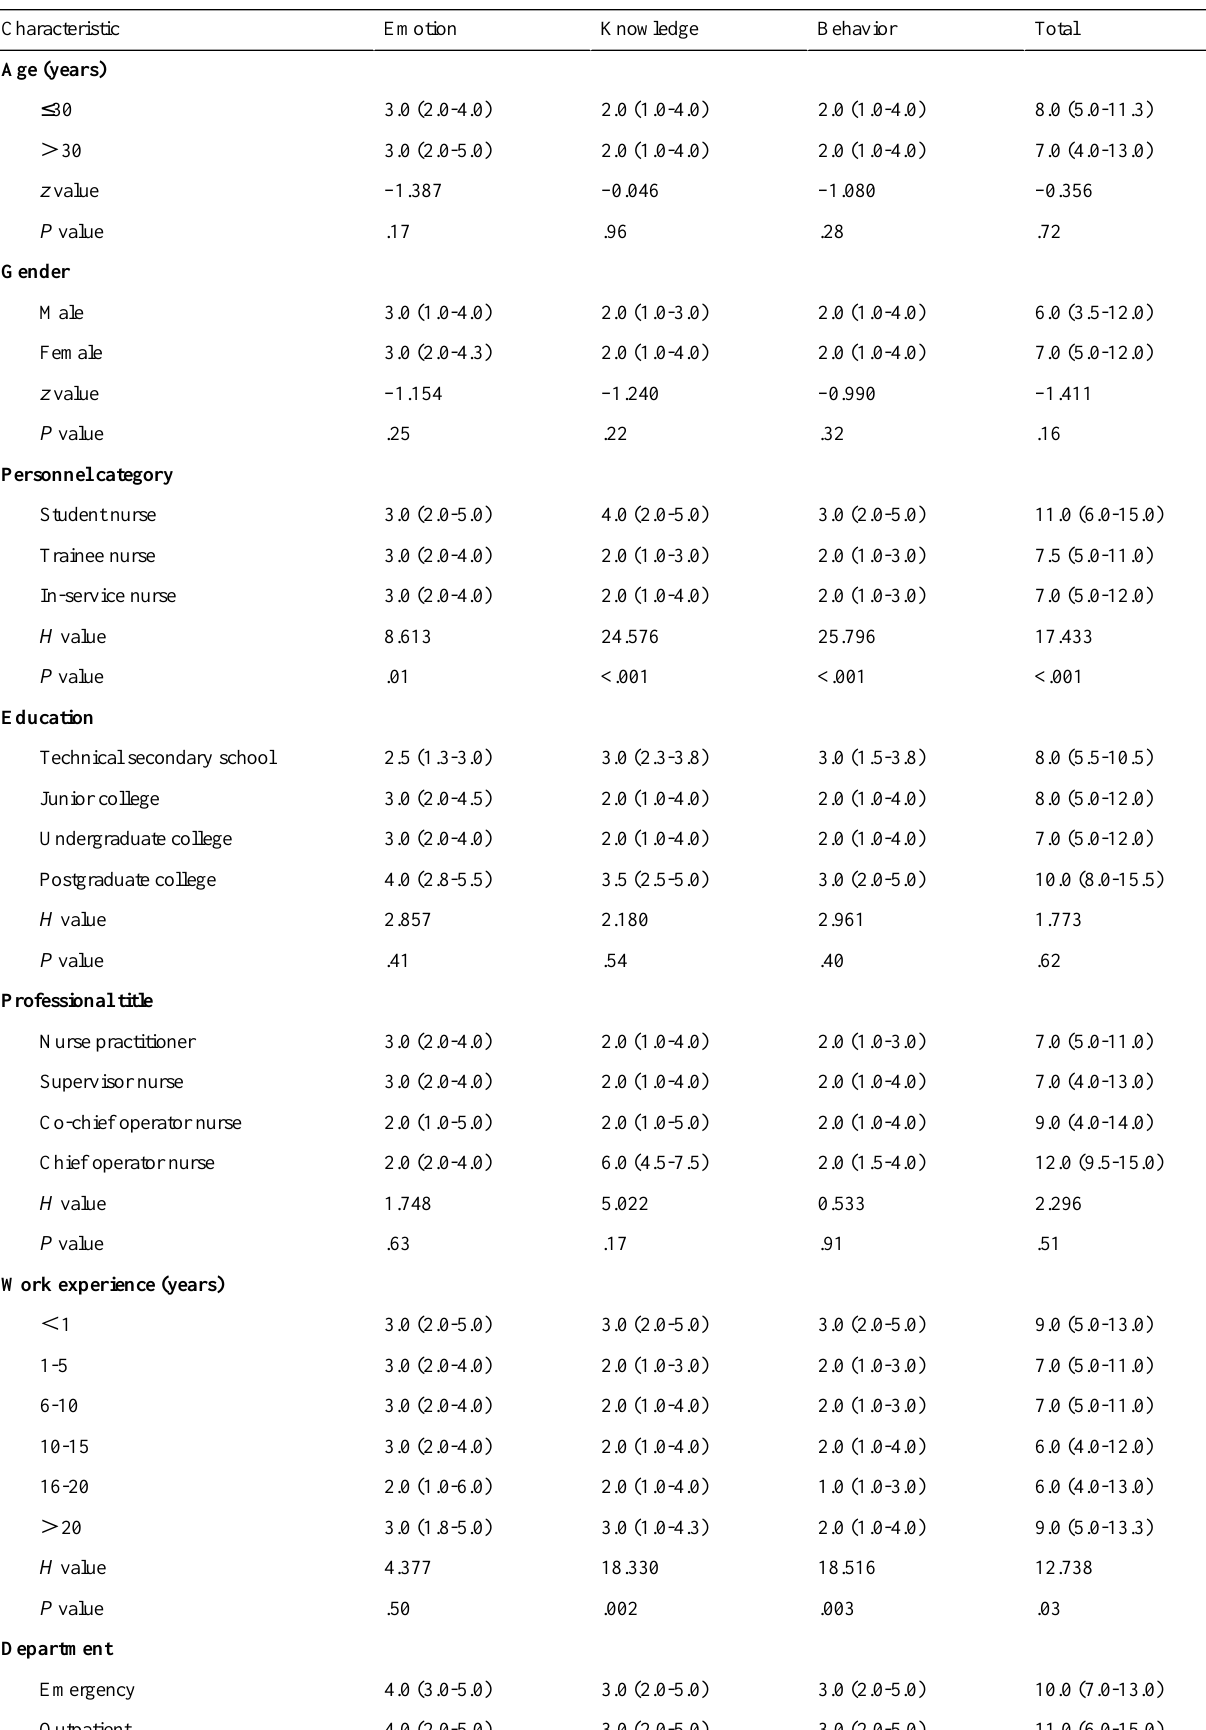
Table 2. Status of psychological stress among nursing staff (N=979) based on their Triage Assessment Form scores, median (IQR).